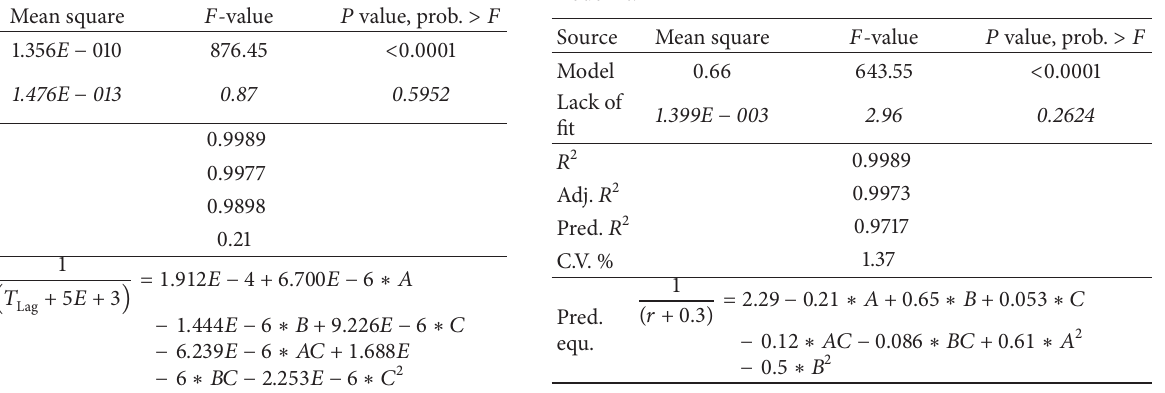
Table 6: Summary of ANOVA for the lag duration model fit. Table 7: Summary of ANOVA for the specific urea hydrolysis rate model